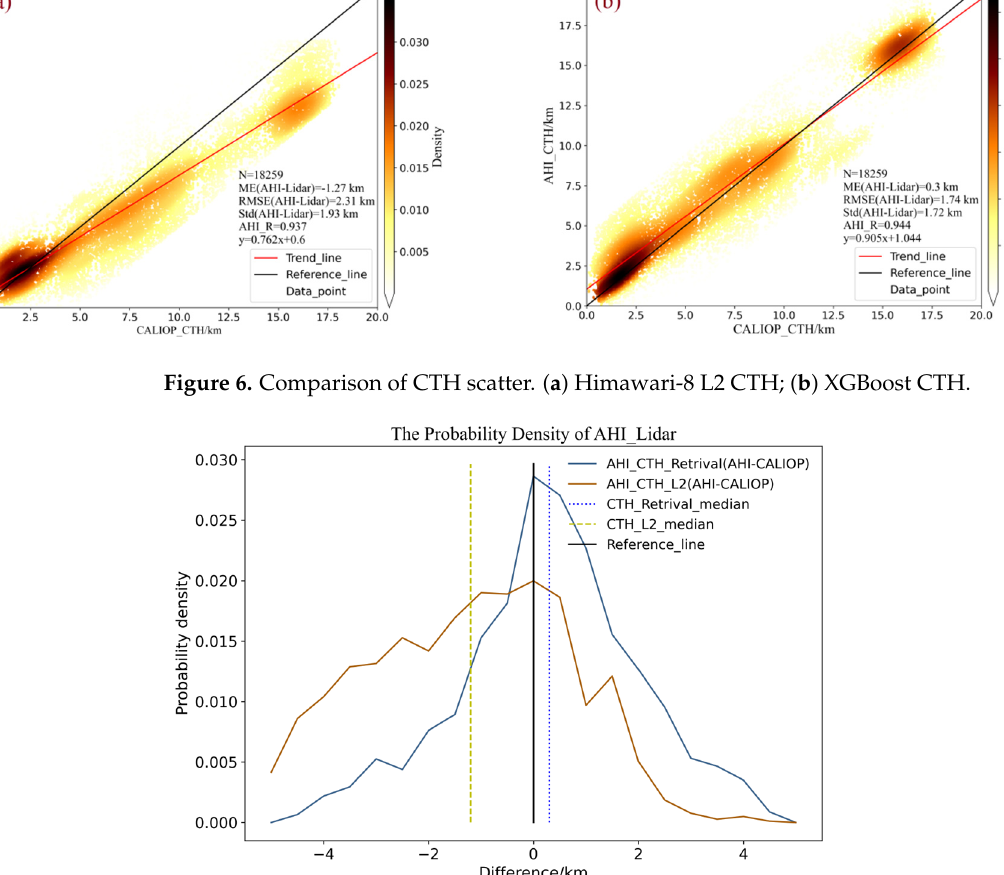
Figure 7. CTH Bias Probability Density Distribution vs. CALIOP.